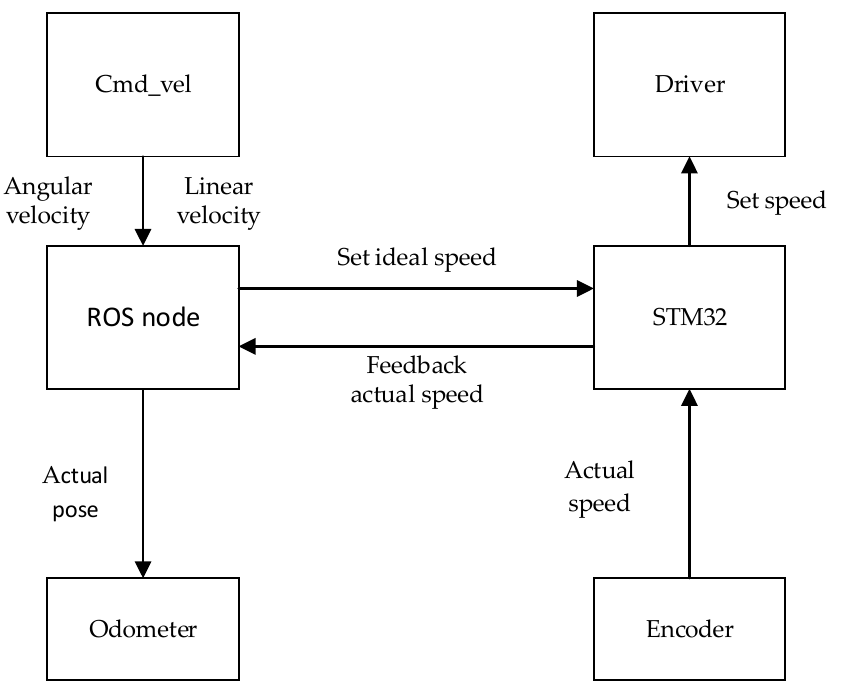
Figure 17. Chassis communication flow.